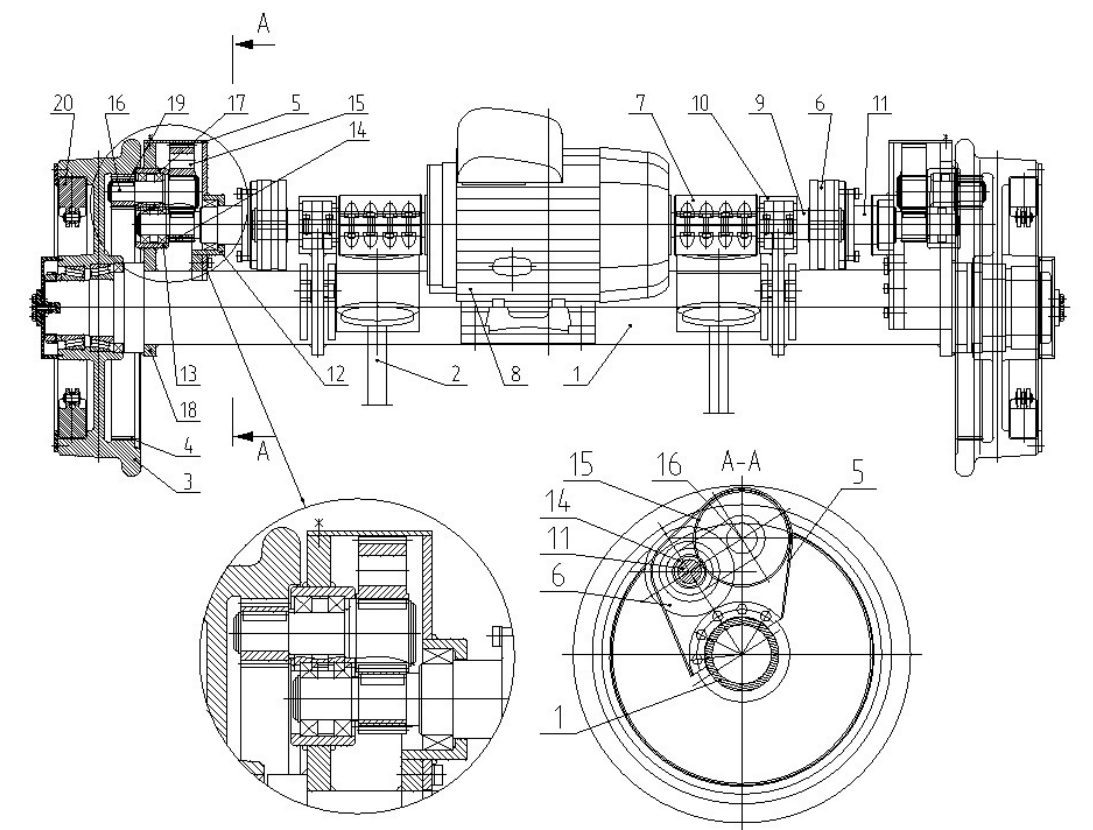
Fig. 7. Rail axle assembly with a double reduction